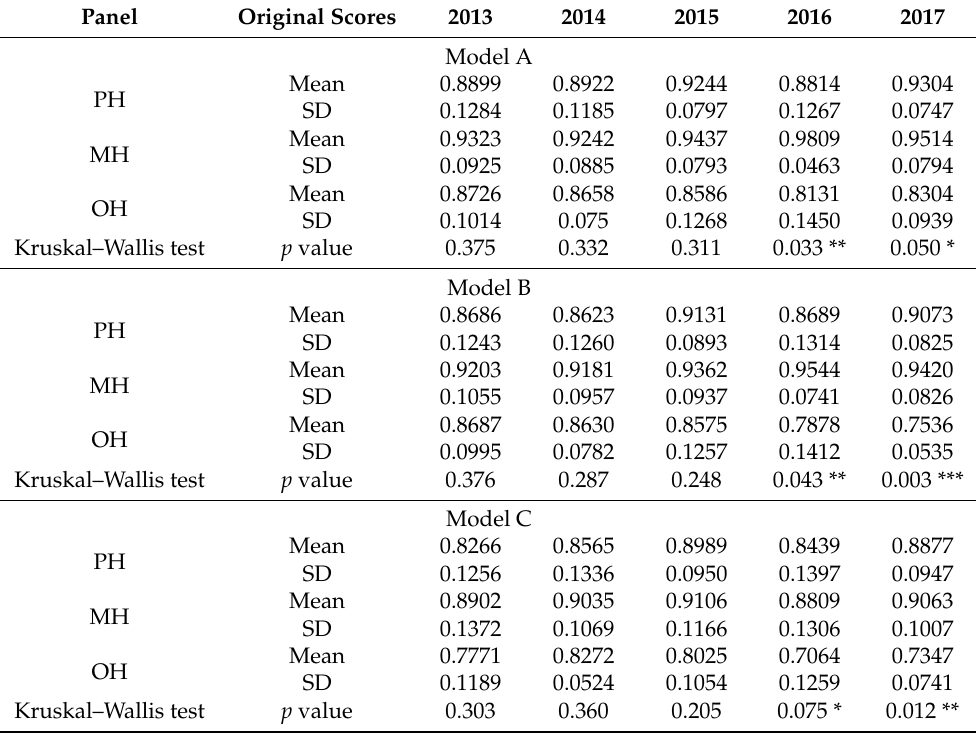
Table 4. Scores for DEA CRS (CCR model) orientated to